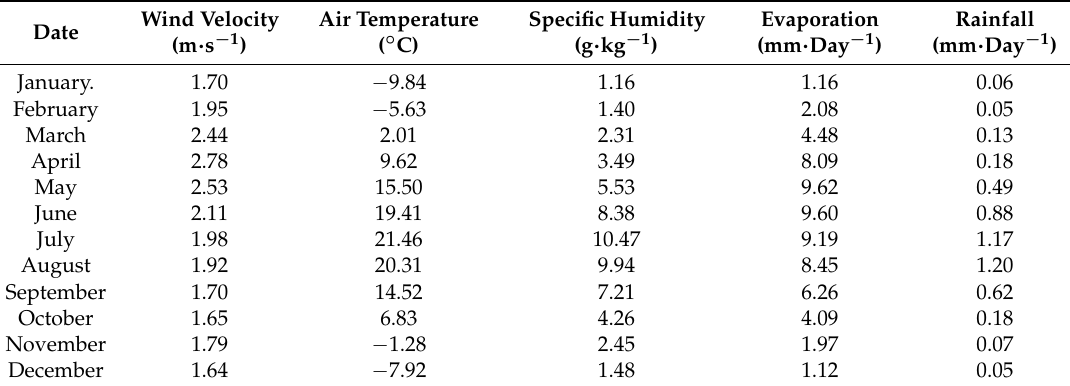
Table 1. Monthly averages of the meteorological elements observed at the Zhangye meteorological station from 1951 to